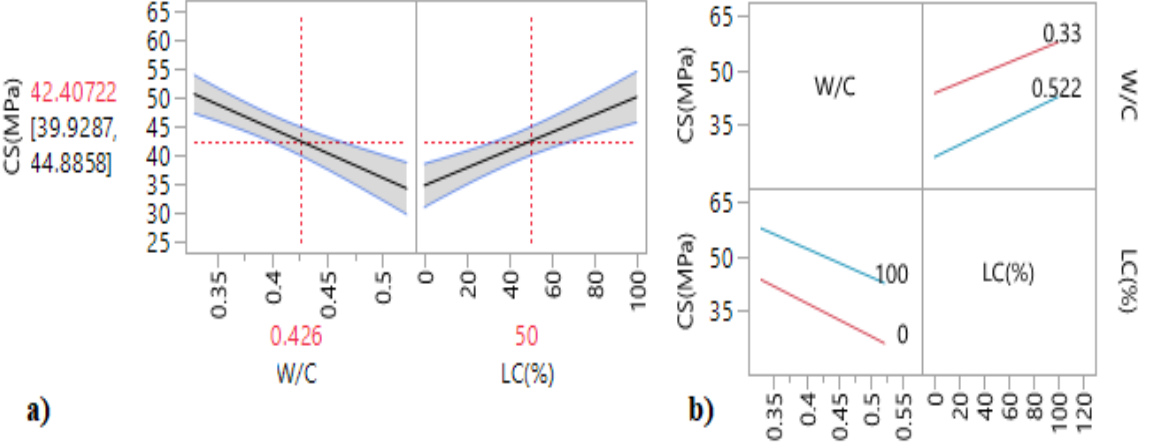
Figure 11. ( a ) Main effect plots and ( b ) interaction plots of the compressive strength of the longitudinal confinement.